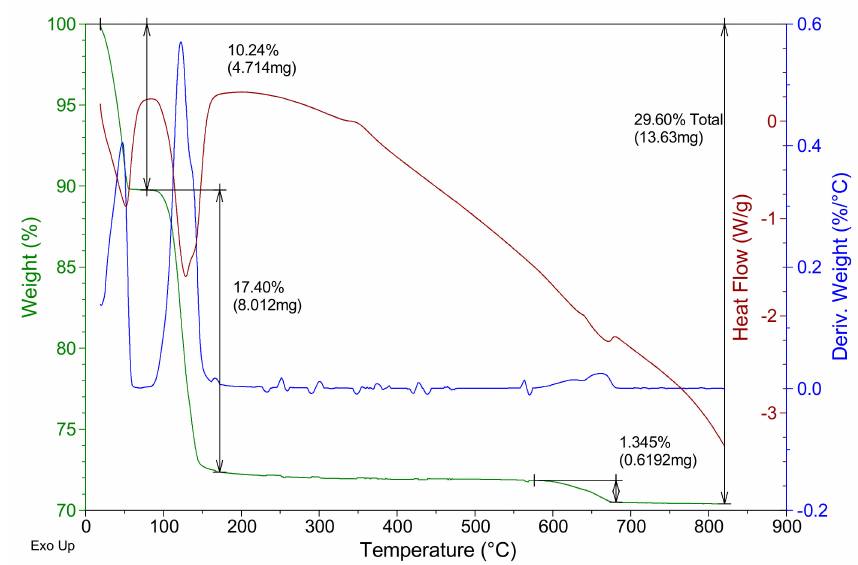
Figure 4. Thermogravimetric analysis of the reference plaster